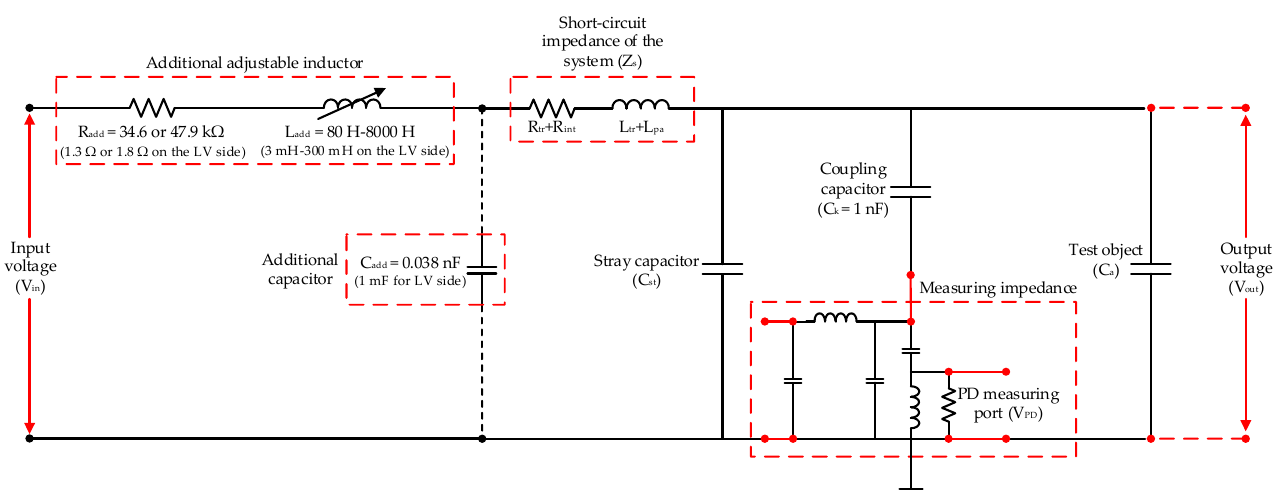
Figure 8. Equivalent circuit of the resonant testing system.